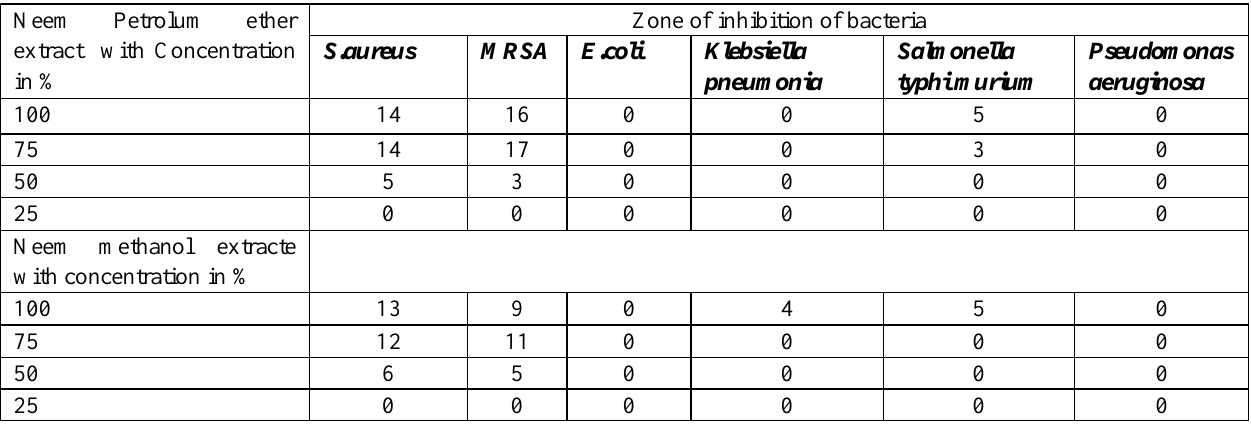
Table 2. The result of commercial antimicrobial disc measured by mm: Antimicrobial discs